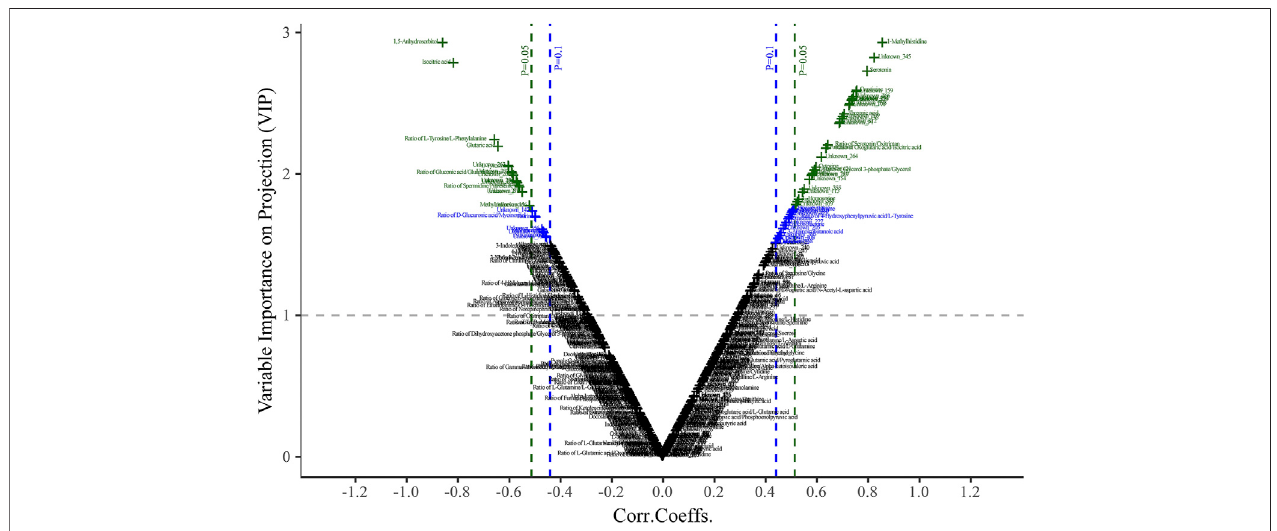
FIGURE5| Plasmavolcano-plotbetweenthecontrolandmodelgroups.Thex-and y -axisrepresentcorrelationcoef fi cients(Corri.Coeffs.)andvariableimportance on projection (VIP) in order.